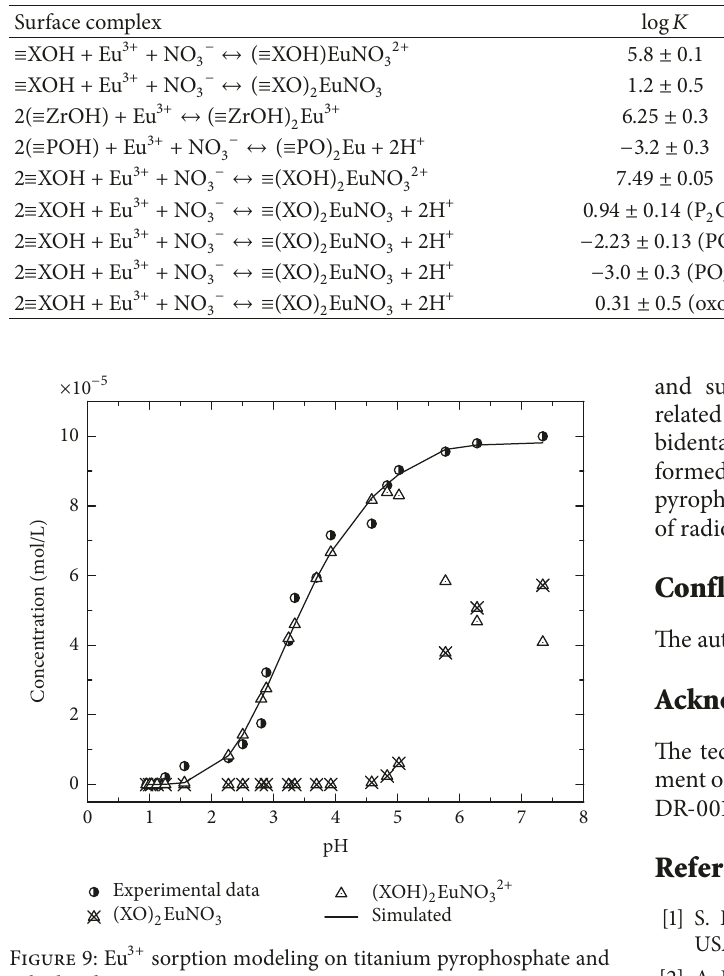
Figure 9: Eu 3+ sorption modeling on titanium pyrophosphate and calculated